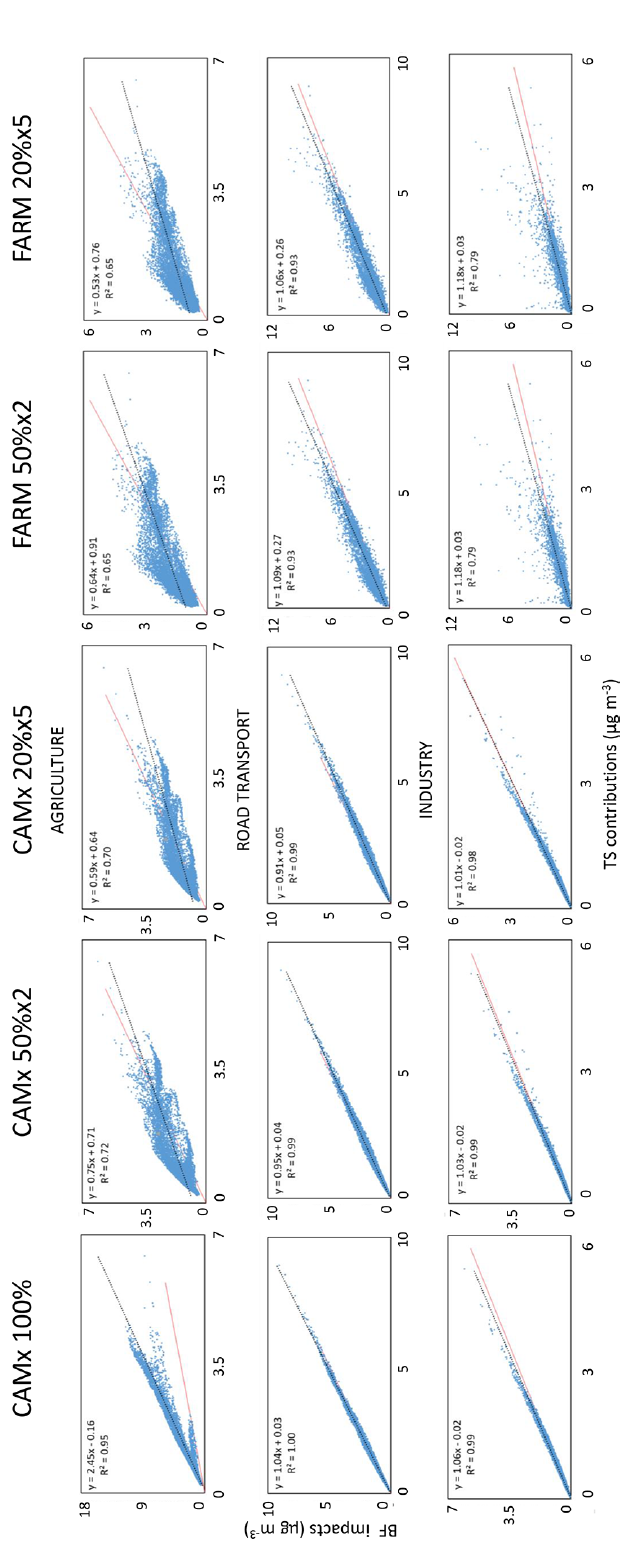
Figure 3. Scatter plots of the single grid cell annual average BF source impacts (CAMx and FARM) on PM 10 versus the TS contributions (CAMx–PSAT) for 100%, 50% (multiplied by 2) and 20% (multiplied by 5) ERLs for AGR, TRA and IND. Dotted line: regression; red line: